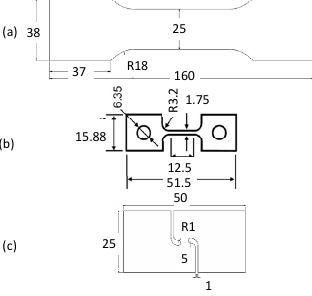
Fig. 1. Specimen geometries used; a) Standard JIS, b) miniature dog-bone and c) mini-shear. All dims in mm.